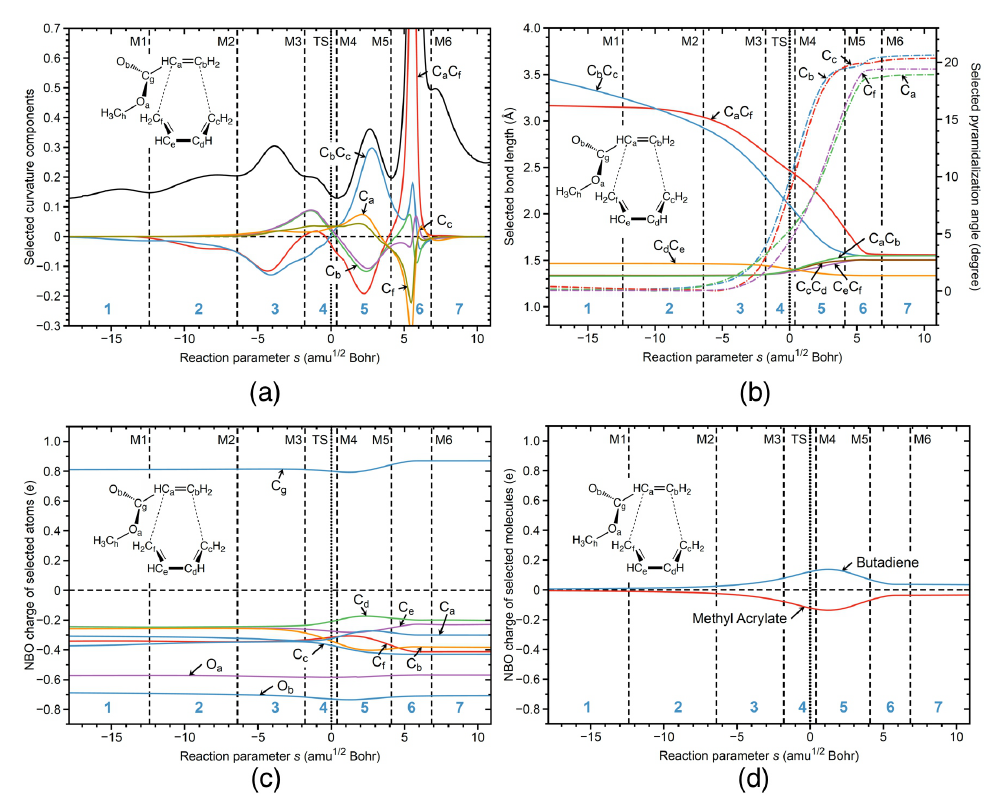
Figure 5. R1nw reaction properties along the reaction path; ( a ) decomposition of the reaction curva- ture into selected components: the bonds shown as two character labels, and the pyramidalization angles shown as a one character label; ( b ) change of the selected geometrical parameters: the bonds shown as two character labels, and the pyramidalization angles shown as a one character label; ( c ) change of the NBO charges of the selected atoms; ( d ) change of the NBO charges of the selected molecules. B3LYP/6-311+G(2d,p)/AMBER level of